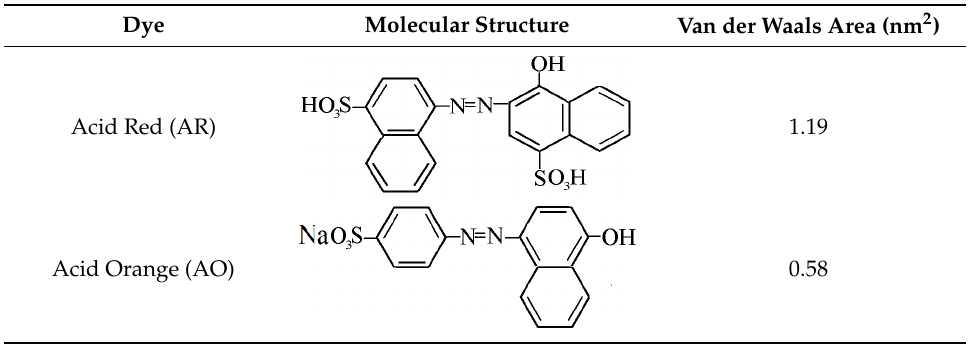
Table 1. Characteristics of the anionic dyes.